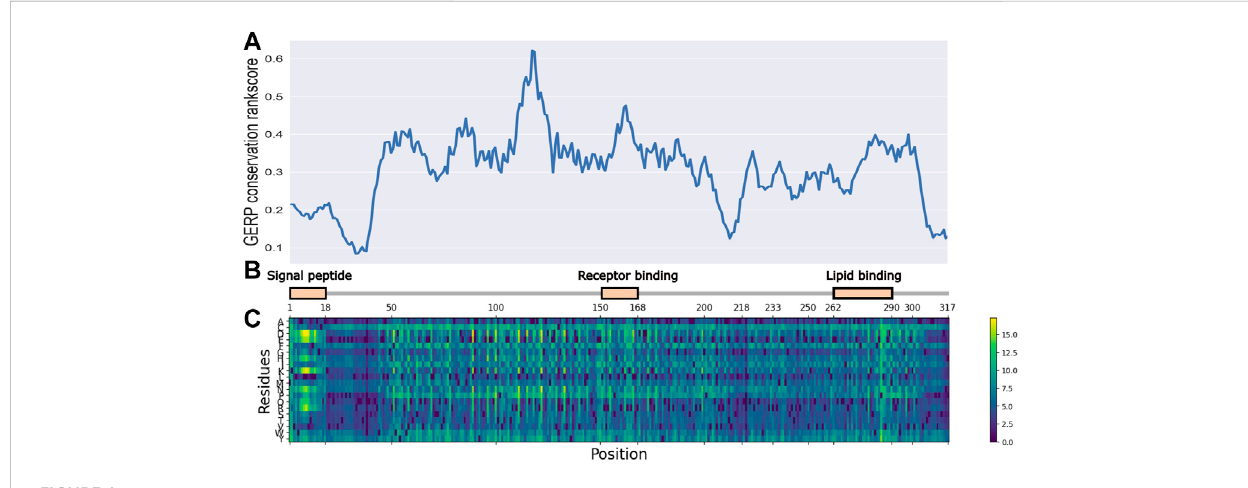
FIGURE 1 ESM-1b and GERP predicted functional importance scores for all potential SAVs in APOE gene. (A) GERP conservation scores for APOE gene. (B) functional domains for APOE gene. (C) ESM-1b in silico mutagenesis predictions for APOE gene.